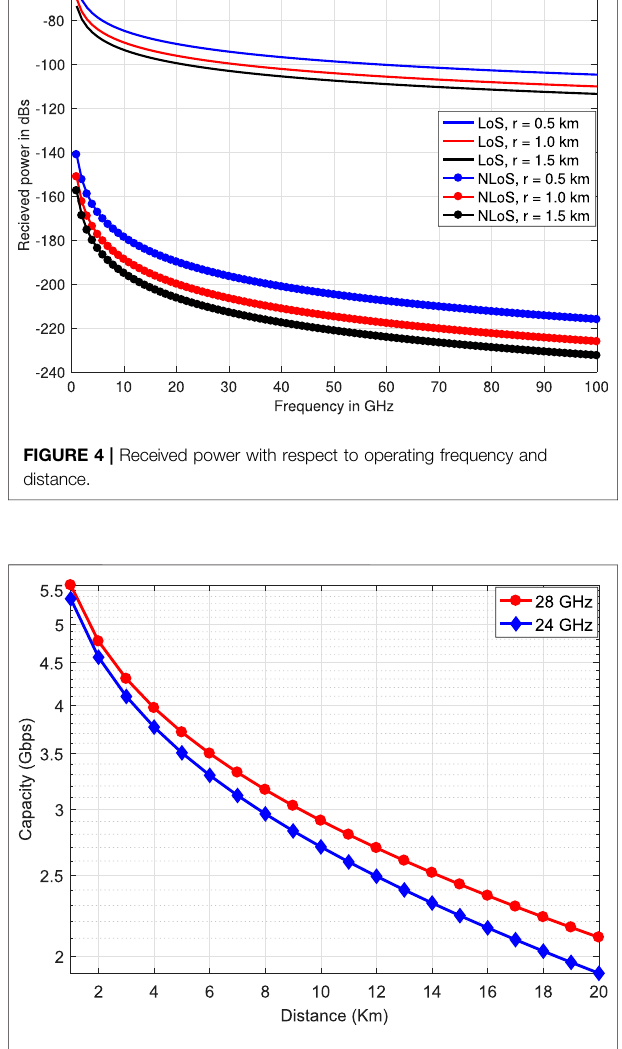
FIGURE 5 | Capacity vs. operating frequency for the TB-to-eVTOL link